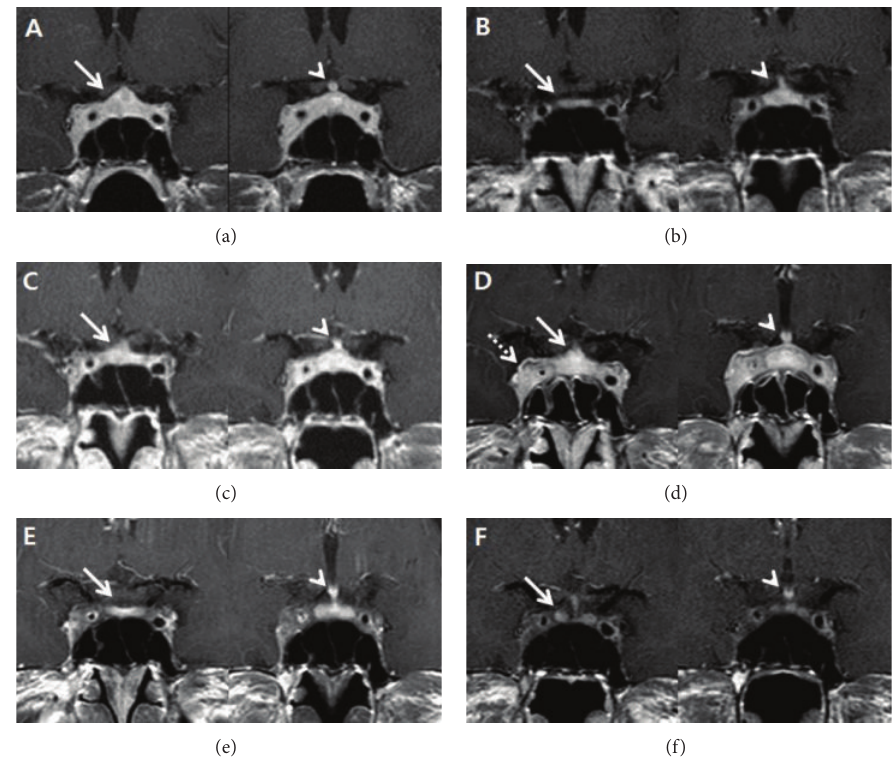
Figure 1: Serial follow-up sellar magnetic resonance image (MRI, contrast enhanced T1-weighted image): (a) initial contrast enhanced image showed suspicious mass of 8mm in size at right pituitary (arrow, nonenhanced portion) and left sided stalk deviation with thickening (arrowhead). (b) Follow-up MRI obtained after 2 years of intermittent empirical steroid therapy for intractable headache showed reduction in the size of pituitary mass (arrow) and improvement of stalk deviation (arrowhead). (c) Follow-up MRI obtained 4 years after initial examination before gamma knife radiosurgery showed regrowth of pituitary mass with stalk deviation (arrow). (d) Follow-up MRI 1 year after gamma knife radiosurgery before high-dose steroid therapy showed remarkable enlargement of the pituitary mass with thickening and deviation of stalk (arrow) and invasion to cavernous sinus (dotted arrow). Significant stenosis of the right cavernous sinus internal carotid artery was present (arrowhead). (e) MRI obtained at 3 months after high-dose steroid therapy showed marked decline in the size of mass at pituitary gland and cavernous sinus (arrow). There was still visible luminal narrowing of cavernous internal carotid artery (arrowhead). There was also less soft tissue surrounding the right internal carotid artery. (f) MRI obtained at 48 months after high-dose steroid therapy showed reduction in the size of the pituitary and cavernous sinus mass (arrow). Thickening of the pituitary stalk was also decreased (arrowhead), and the soft tissue surrounding the right internal carotid artery was